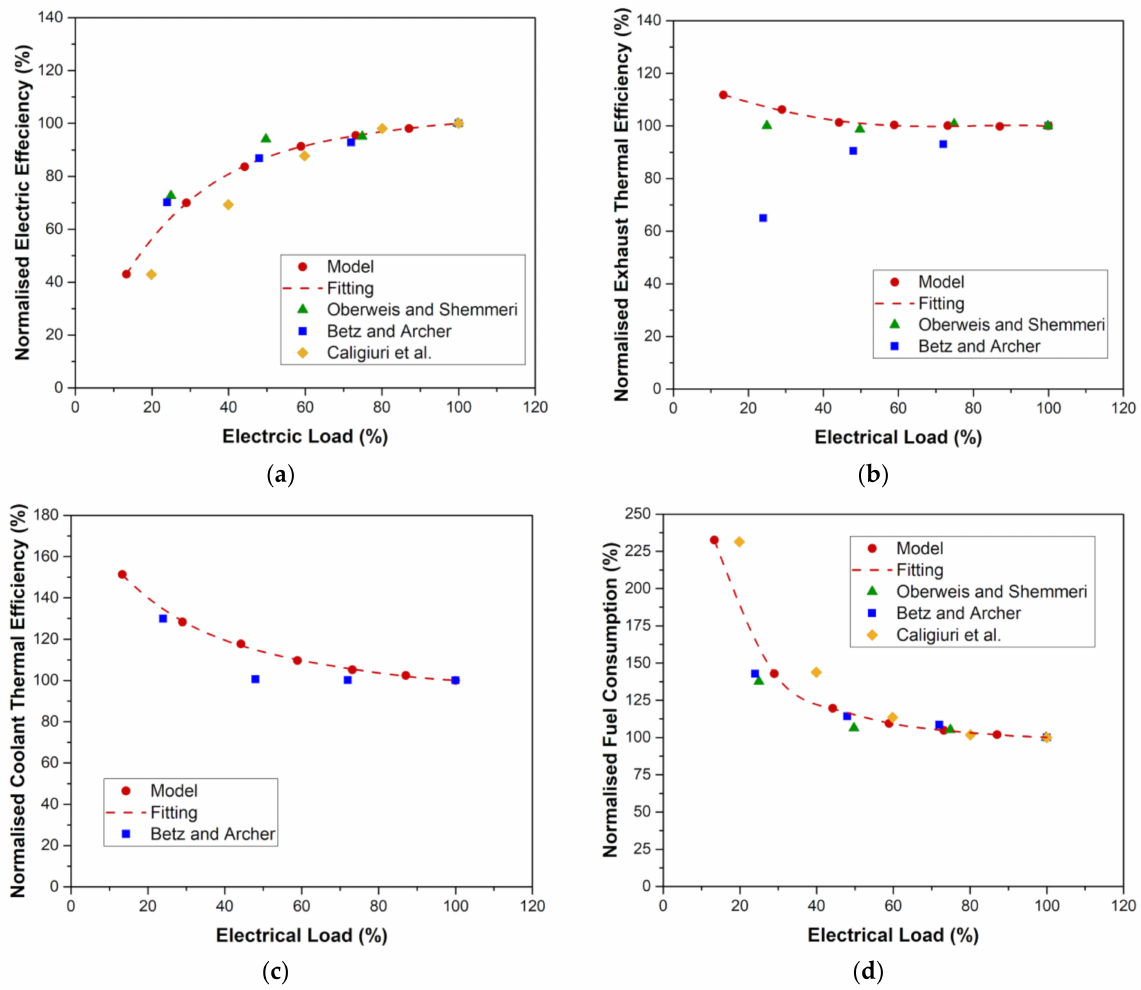
Figure 7. CHP performances in terms of normalised parameters and comparison with experimental data: ( a ) electric efficiency; ( b ) exhaust thermal efficiency; ( c ) cooling circuit thermal efficiency; ( d ) fuel consumption. Authors elaboration on experimental literature data